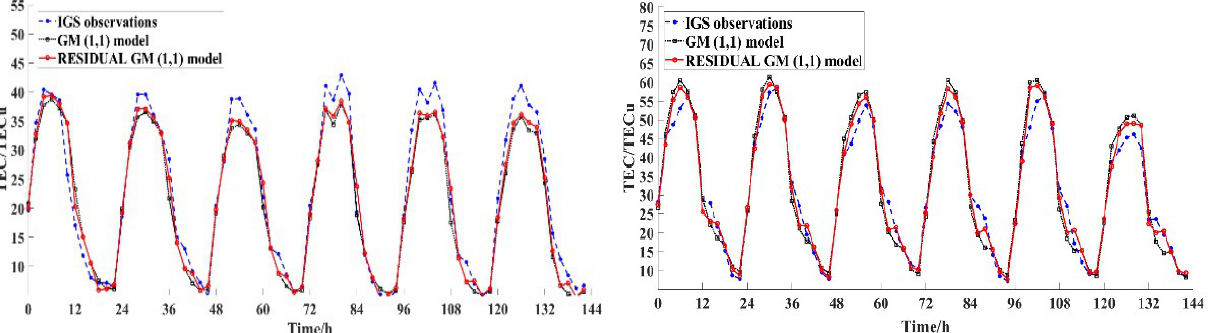
Figure 1. TEC forecast for 6 days in spring at low latitudes